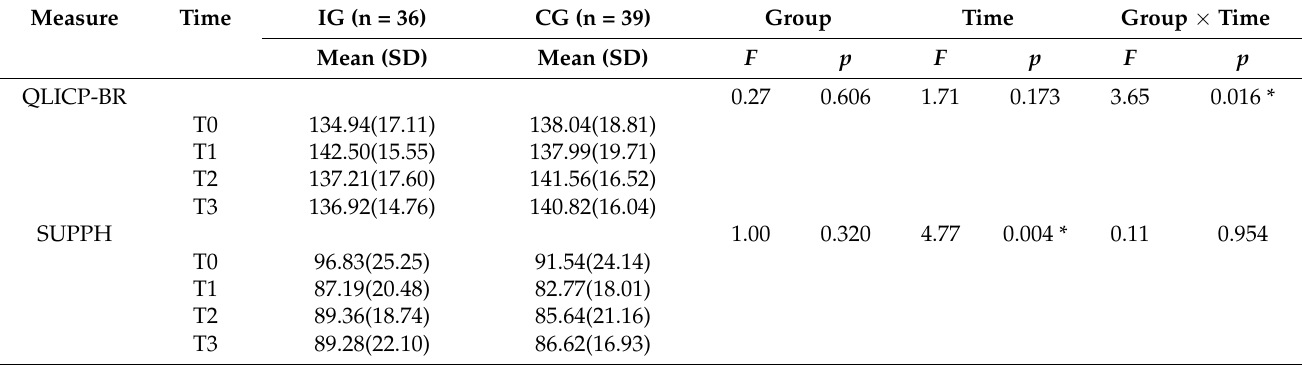
Table 3. Scores of QoL and self-care self-efficacy, and results of repeated-measures